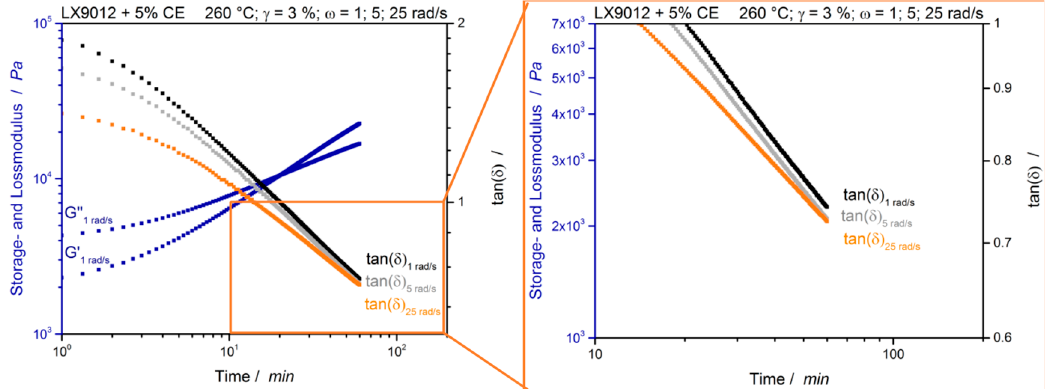
Figure 11. LX9012 with 5% CE measured at 260 °C. tan( δ ) of different simultaneous measured frequencies for the evaluation of the gel-point.